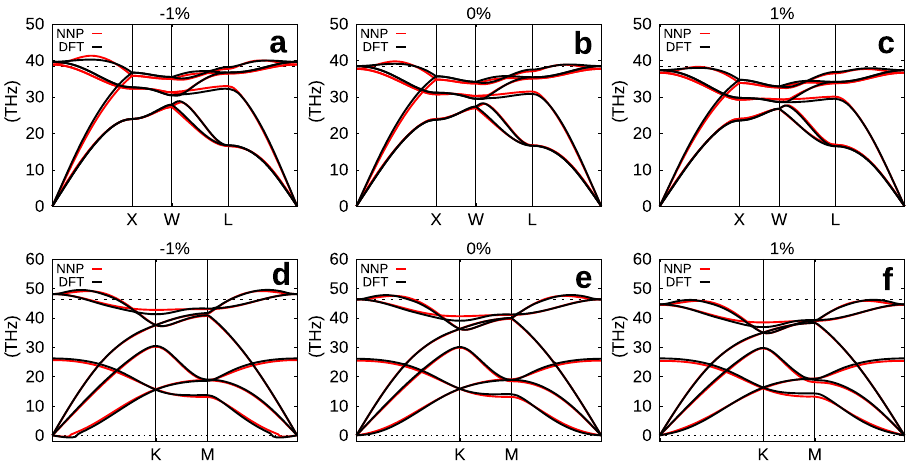
Fig. 4 Phonon dispersion at equilibrium and deformed geometries. The phonon dispersion along the high symmetry lines of diamond and graphene is reported in a – c and d – f , respectively. The value at the top of each graph represent the percentage of expansion (positive) or compression (negative) of the lattice parameter. The dotted black line is the maximum frequency in THz at the Γ point at equilibrium lattice